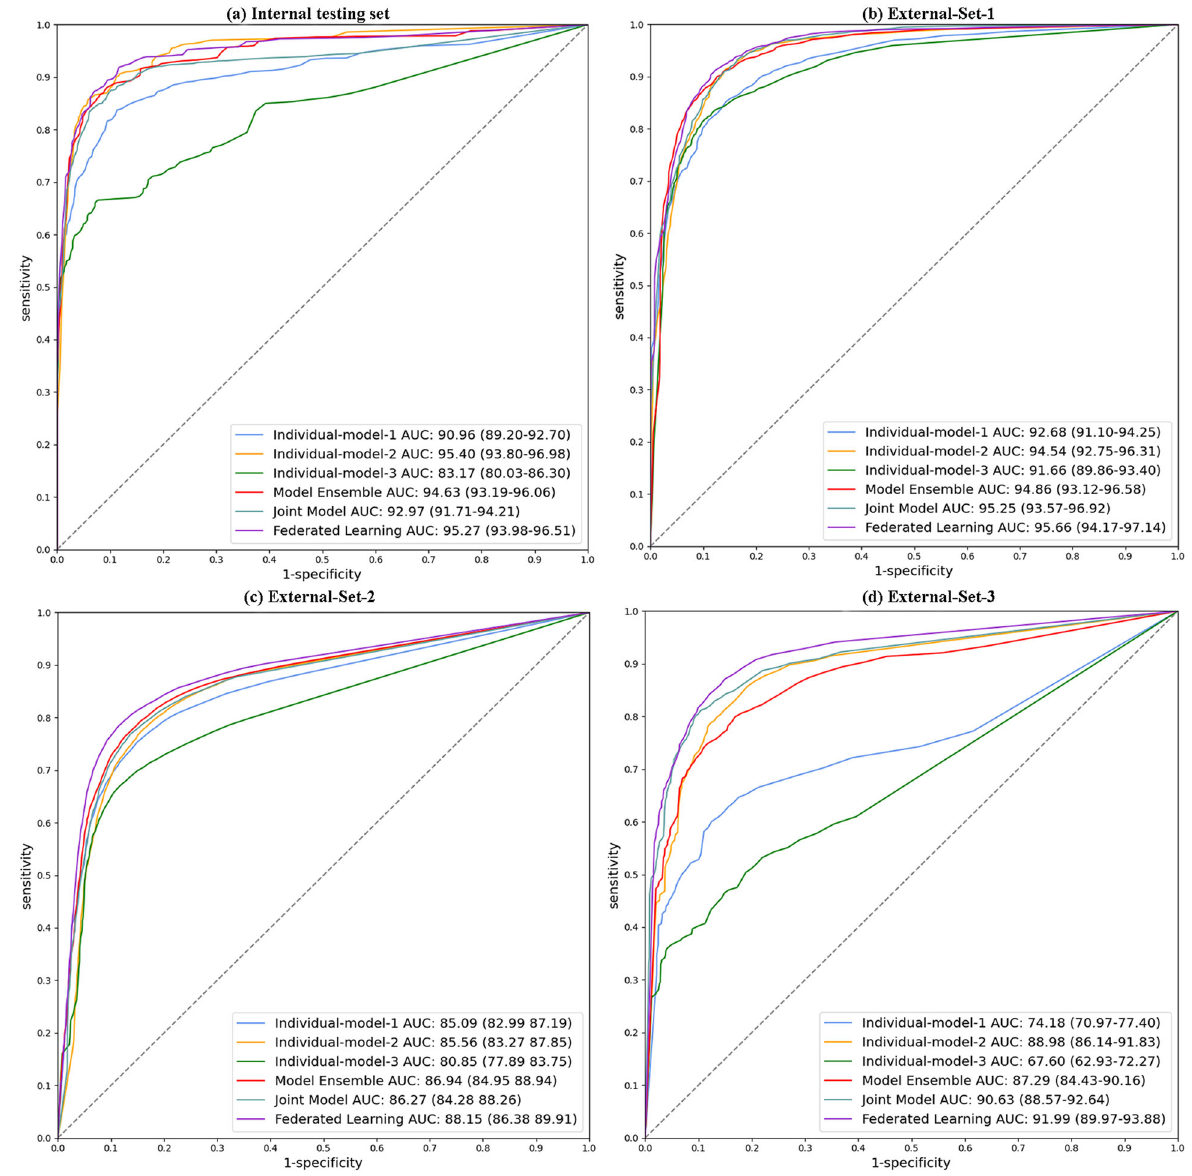
Fig. 2 ROC curves for lesion detection on the internal testing set and three external validation sets. Results of six settings are compared, including individual-model-1, individual-model-2, individual-model-3, their model ensemble, their joint training model, and our federated learning model. The results of AUC are presented with 95%